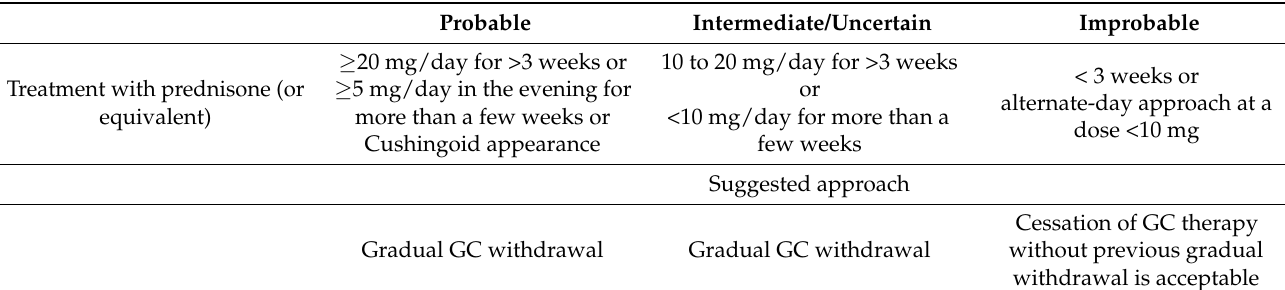
Table 2. Estimated risk of the suppression of the HPA axis with glucocorticoid therapy. Probable Intermediate/Uncertain Improbable ≥ 20 mg/day for >3 weeks or 10 to 20 mg/day for >3 weeks < 3 weeks or ≥ 5 mg/day in the evening for Treatment with prednisone (or or alternate-day approach at a <10 mg/day for more than a equivalent) more than a few weeks or dose <10 mg few weeks Cushingoid appearance Suggested approach Cessation of GC therapy Gradual GC withdrawal Gradual GC withdrawal without previous gradual withdrawal is